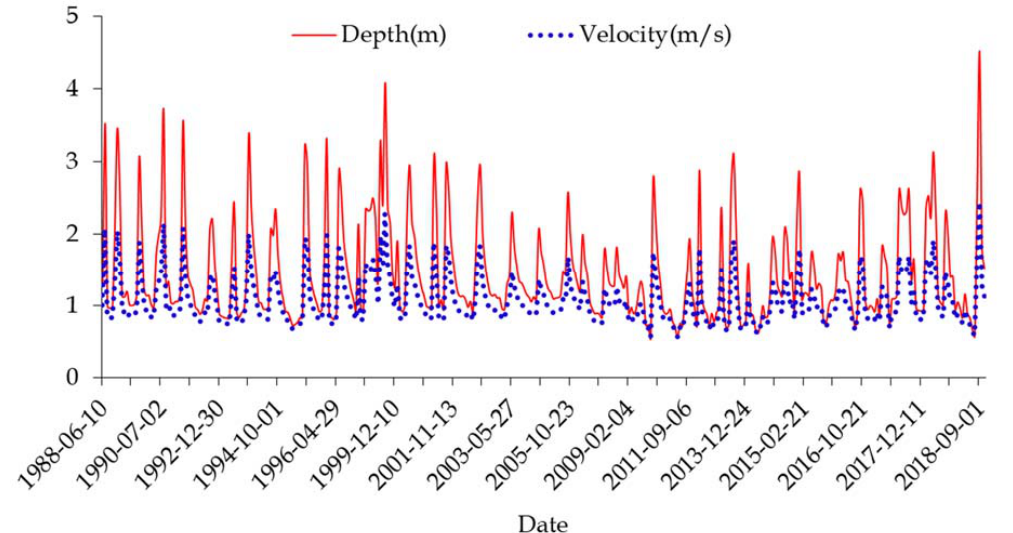
Figure 6. Time series of average depth calculated using Equation (4) and average velocity calculated using Equation (5) at Lhasa gauge from 1988 to 2018.